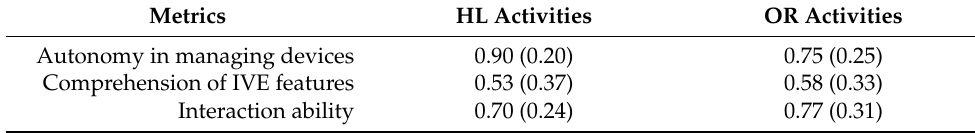
Table 5. Summary of usability evaluation: mean scores with standard deviation.